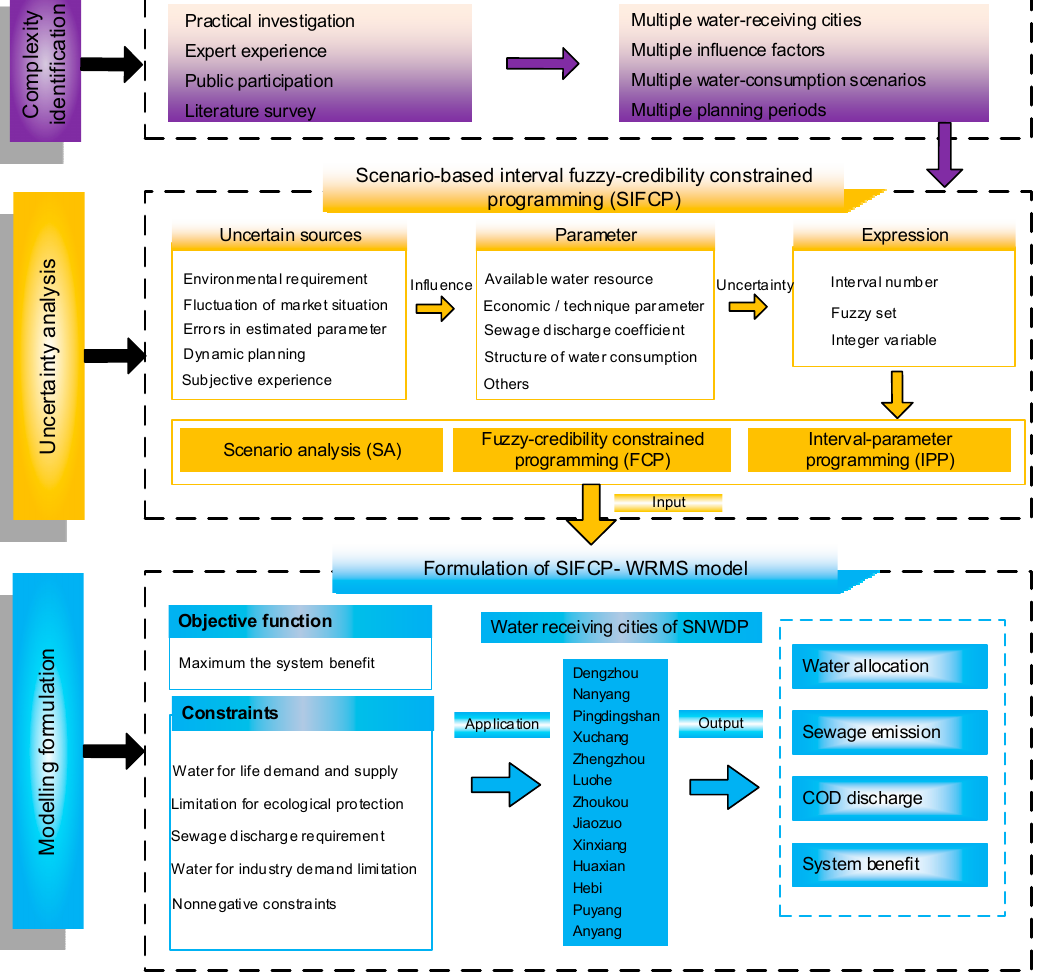
Figure 1. Formulation of the SIFCP-WRMS model.